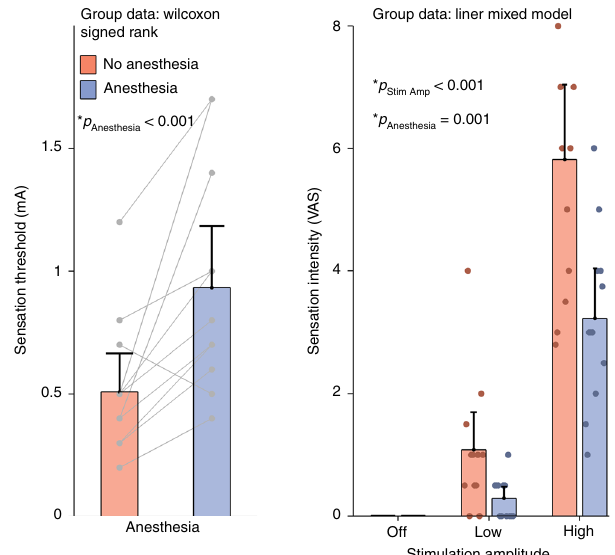
Fig. 5 Sensation threshold and intensity ratings. The left panel shows the mean sensation threshold amplitude (mA) for the anesthesia (blue) and no anesthesia conditions (red). Error bars on both panels show the con fi dence intervals. Individual data points are shown as gray dots and lines connect points from the same subject. Topical scalp anesthesia caused a signi fi cant increase in sensation threshold ( p < 0.001, one-sided Wilcoxon signed rank test). The right panel shows the mean sensation intensity rating for all subjects, using a visual analog scale (VAS) during OFF, LOW and HIGH amplitude stimulation conditions and during the anesthesia and no anesthesia conditions. Individual data points are shown as dots. The sensation intensity signi fi cantly increases with increasing stimulation amplitude ( p < 0.001, linear mixed model). Additionally, the application of topical scalp anesthesia signi fi cantly reduces sensation intensity ratings ( p = 0.001, linear mixed model). Both panels con fi rm that topical anesthesia does indeed block peripheral nerves in the